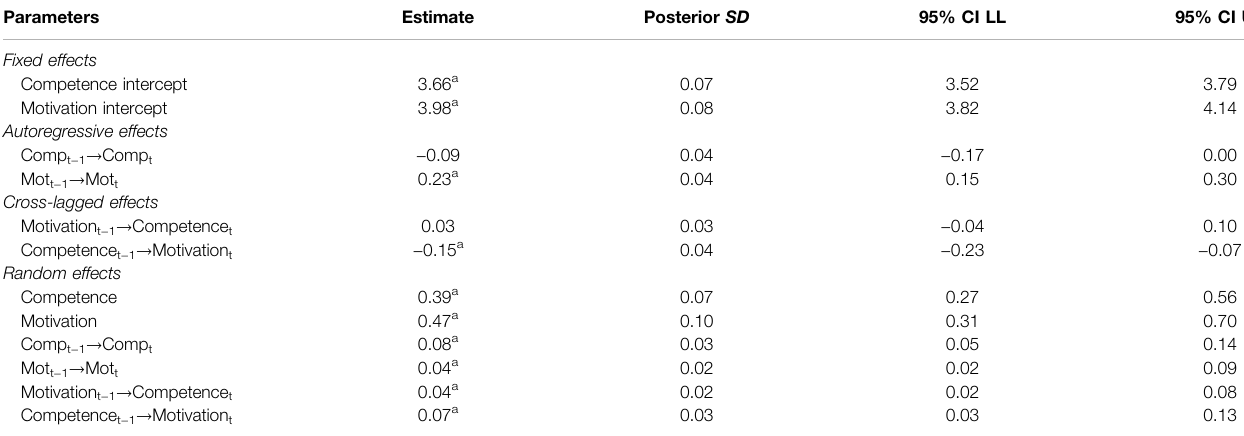
TABLE 5 | Unstandardized parameter estimates or the multilevel bivariate autoregressive model ’ s analysis of the associations between feelings of competence and momentary motivation in pre-service teachers conducting science experiments. Parameters